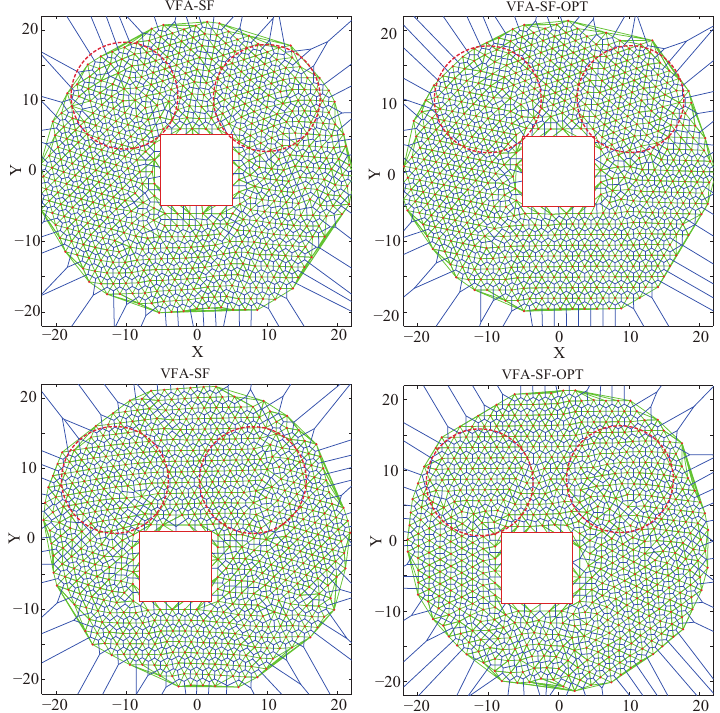
Figure 8. Final node deployments from ( left ) the VFA-SF and ( right ) the VFA-SF-OPT for the square obstacle cases: ( top ) when square obstacle is at the center; ( bottom ) when the square obstacle is off-center. Red dashed circles, region used to calculate the PCD values.